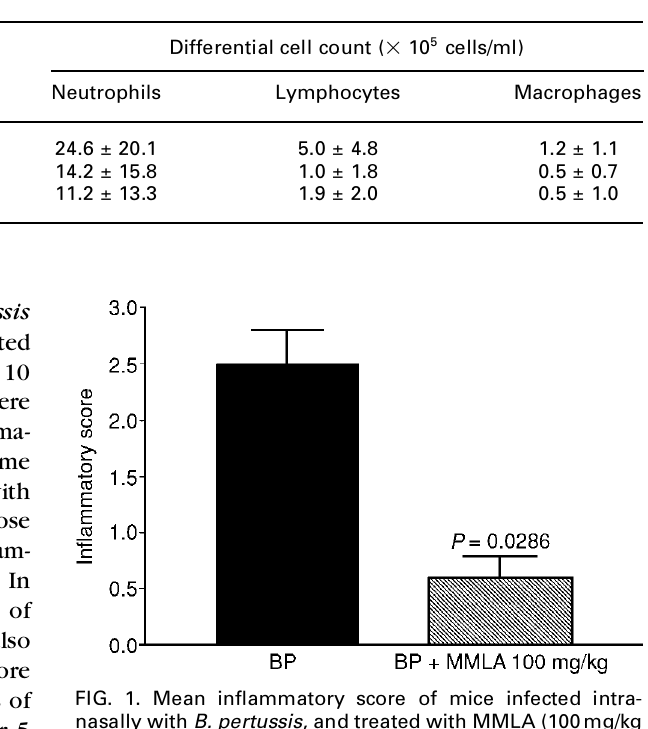
Table 1. Effect of MMLA, given at various concentrations intraperitoneally in a single dose, on cells recovered from bronchoalveolar lavage fluid of mice intranasally infected with B. pertussis (six mice for each experimental group). Mice were sacrified 10 days after infection.